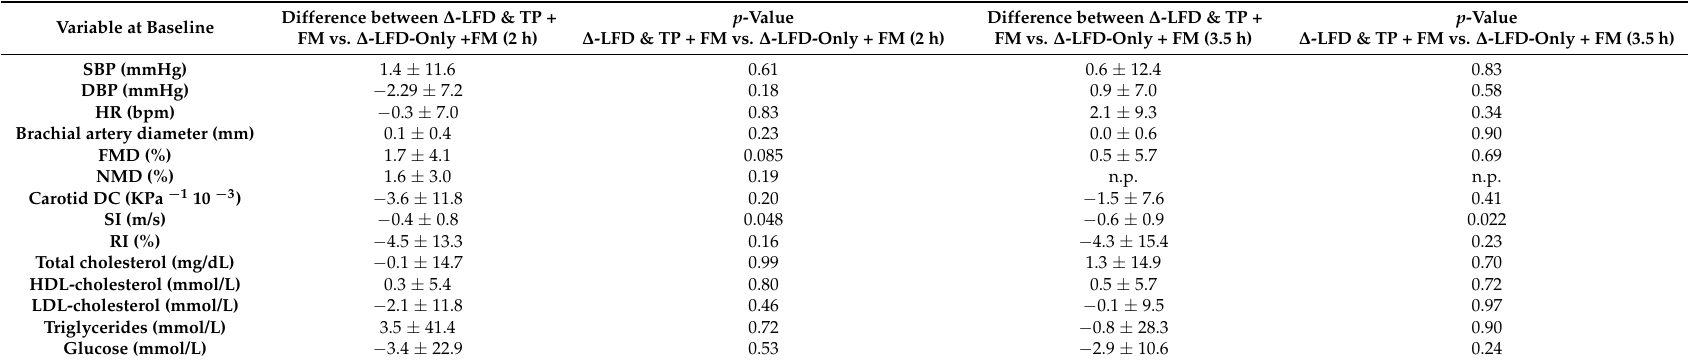
Table 3. Difference between volunteers who consumed a LFD and TP + FM with respect to LFD-only + FM in the changes with respect to baseline of BP, vascular exams and metabolic